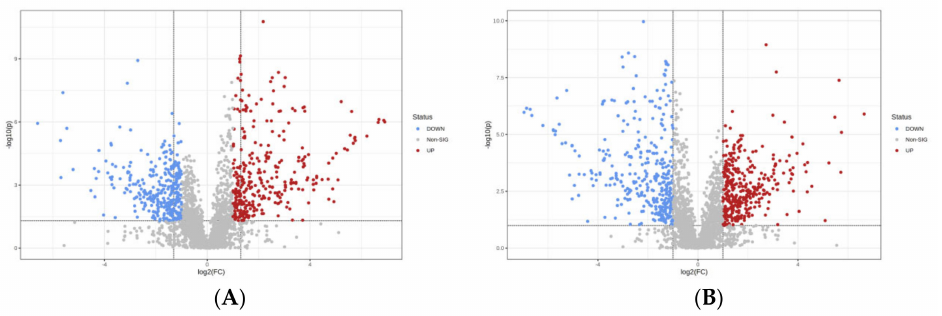
Figure 5. Volcano plot of OPLS-DA displacement test of blank control group vs. model control group (( A ): Negative ion mode, ( B ): Positive ion mode). Table 3. Detailed information of the different lipids between the blank group and model